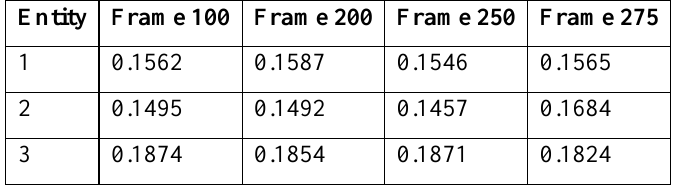
Table 7 The completeness distance index E X experiment result table of track system simulation and acquisition source